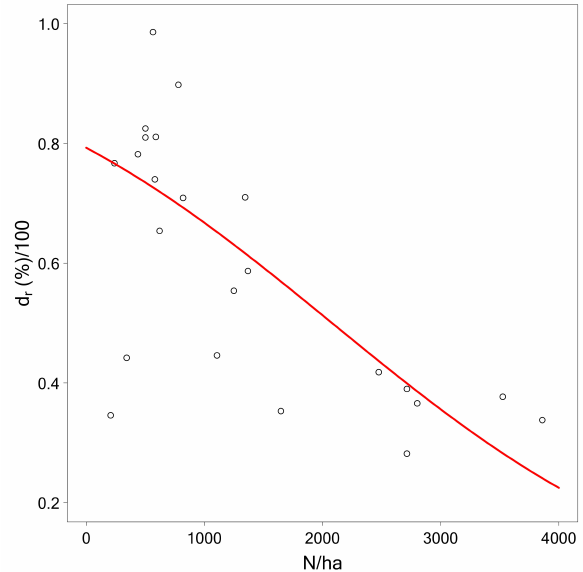
Figure A7. Detection rate over number of stems per hectare. Bold red line indicates logistic response curve. Points indicate